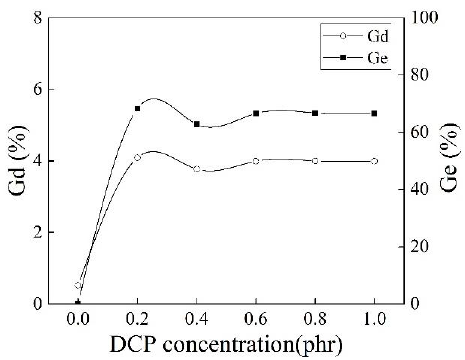
Figure 6. Effect of different DCP concentrations on Gd and Ge of iPB-g-MAH.